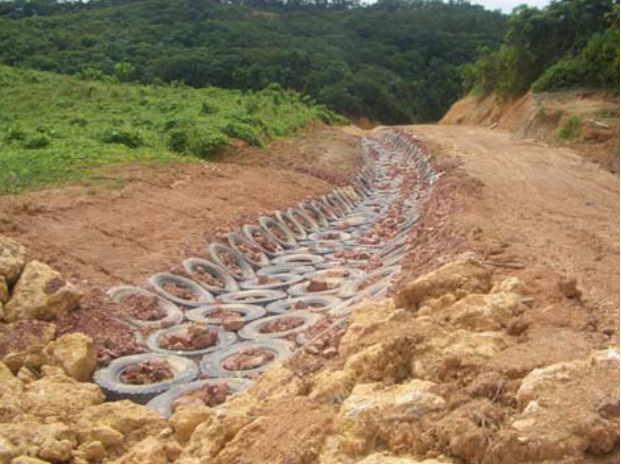
Figure 3. The drainage system constructed and reinforced with stone or other materials to reinforce the drain base.